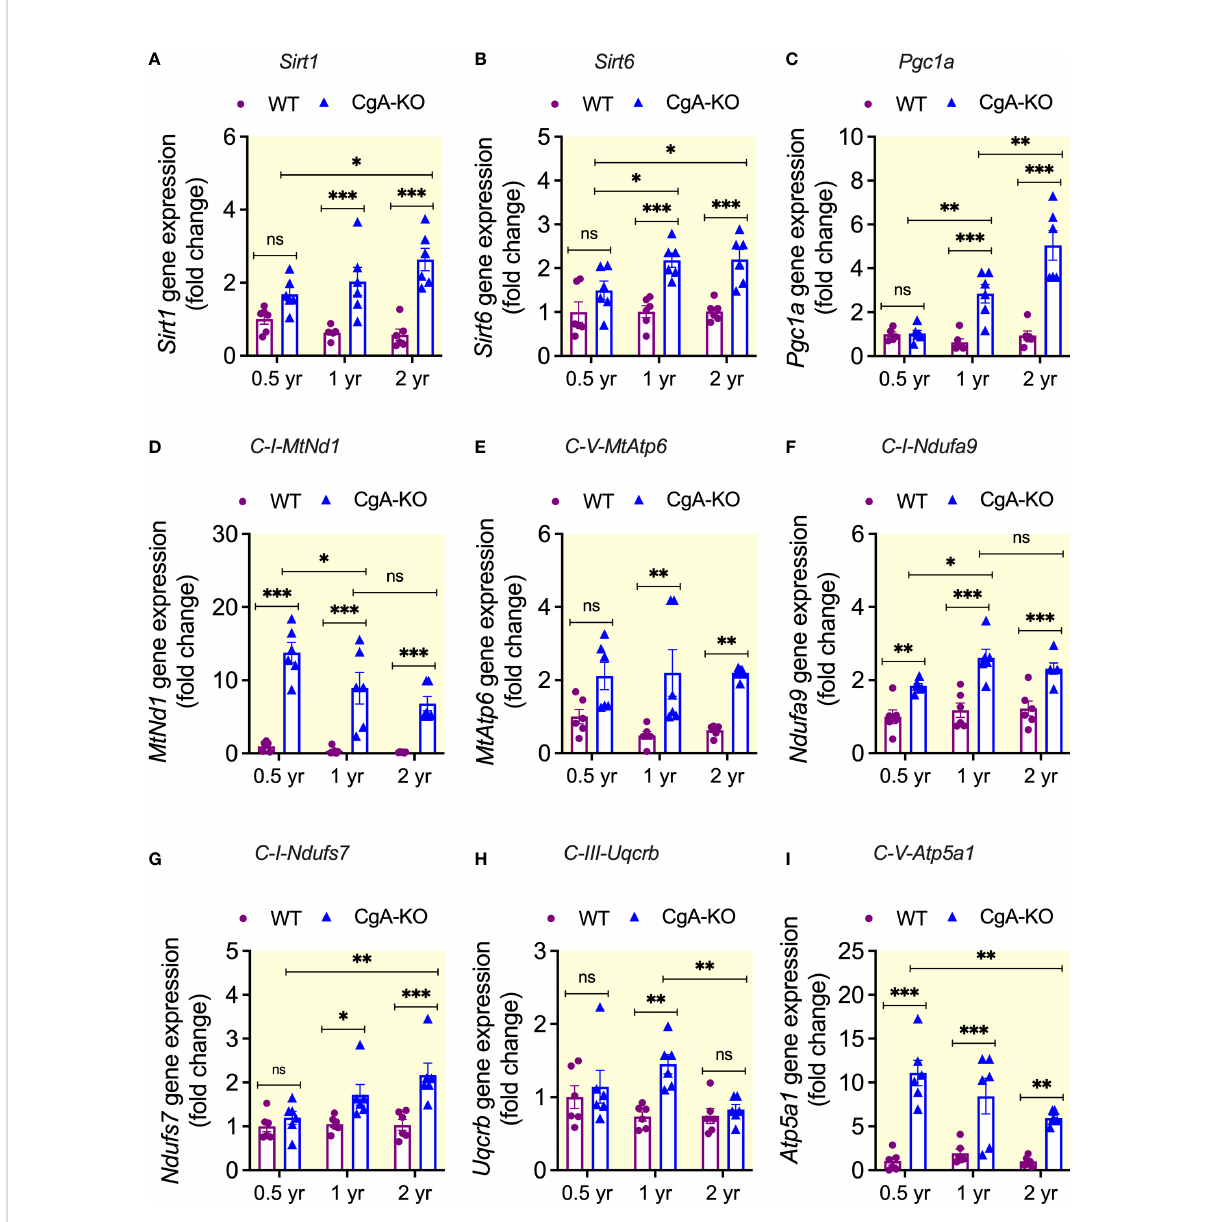
FIGURE 8 Increased expression of mitochondrial genes in CgA-KO mice. Expression of genes involved in mitochondrial biogenesis in the liver of WT and CgA- KO mice. 2-way ANOVA was used to analyze the following genes (n=6): (A) Sirt1 . Interaction: p < 0.05; Genotype: p < 0.001; Age: ns. (B) Sirt6 . Interaction: ns; Genotype: p < 0.001; Age: ns. (C) Pgc1a . Interaction: p < 0.001; Genotype: p < 0.001; Age: p < 0.001. Expression of mitochondrially encoded genes: (D) MtNd1 . Interaction: p < 0.05; Genotype: p < 0.001; Age: p < 0.01. (E) MtAtp6 . Interaction: ns; Genotype: p < 0.001; Age: ns. Expression of nuclear-encoded genes: (F) Ndufa9 . Interaction: ns; Genotype: p < 0.001; Age: p < 0.05. (G) Ndufs7 . Interaction: p < 0.05; Genotype: p < 0.001; Age: p < 0.05 (H) Uqcrb . Interaction: ns; Genotype: p < 0.01; Age: ns. (I) Atp5a1. Interaction: ns; Genotype: p < 0.001; Age: ns. *P < 0.05; **P < 0.01; ***P <